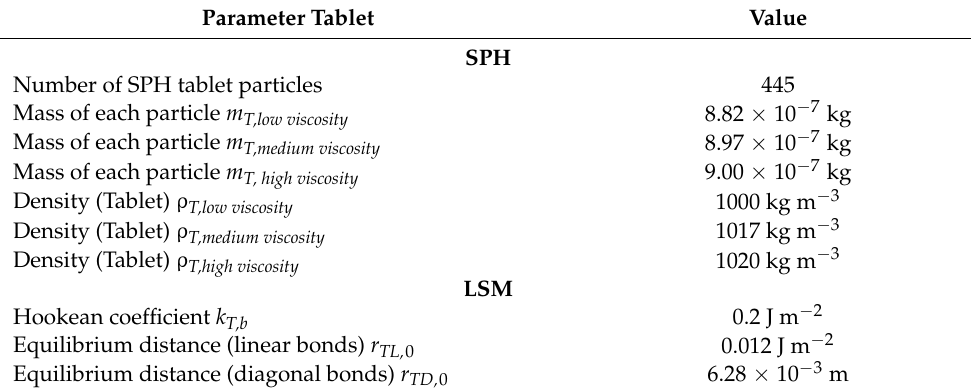
Table 4. Model parameter of the